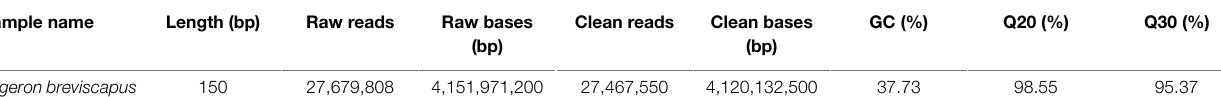
TABLE 1 | Sequencing data volume information